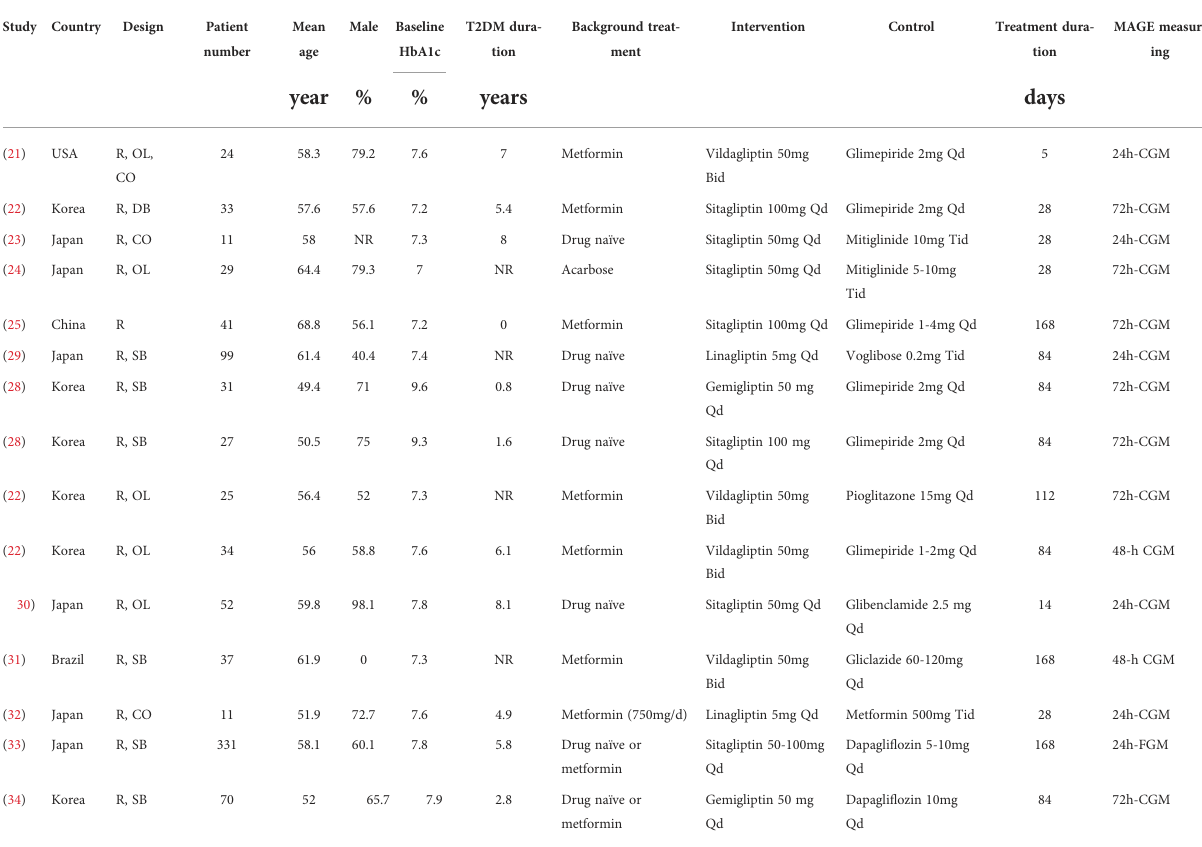
TABLE 1 Characteristics of the included RCTs.